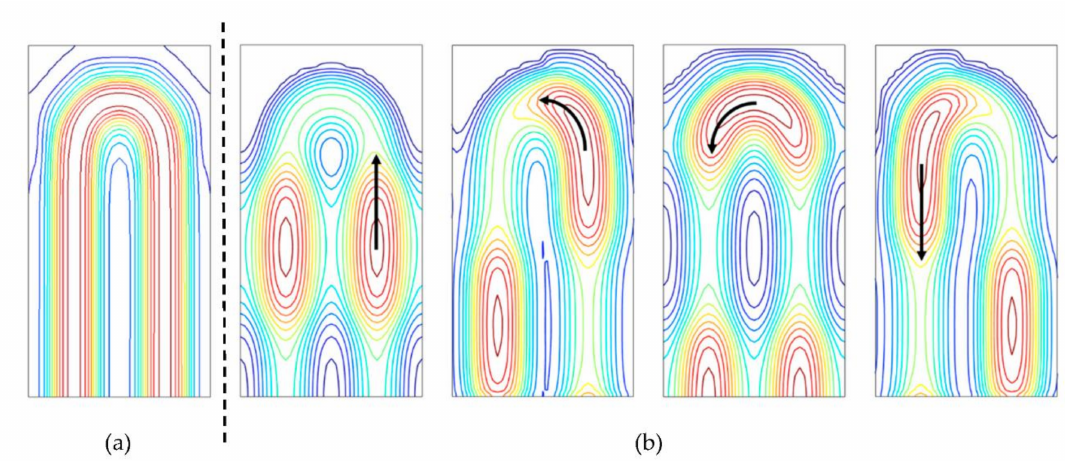
Figure 7. Potential profiles at a bend ( a ) in the design, the same high driving voltage (VH) is applied to the bend area without the electrode gaps, and the channel potential is flattened with the allowance of 0.05 V difference. ( b ) Changes in the electrodes with the high voltage VH in turn transport the signal charge